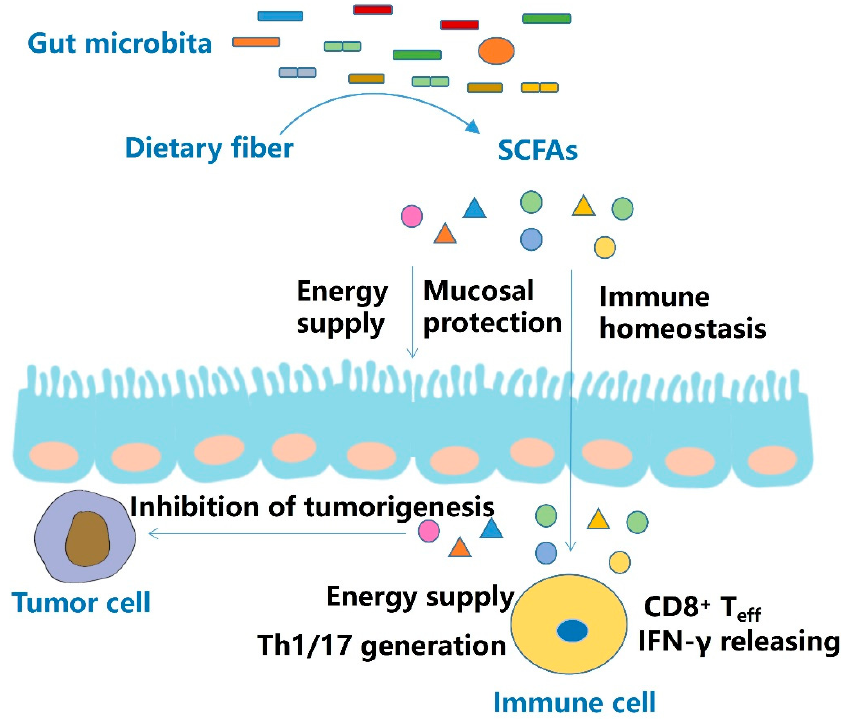
Figure 1. Effect and mechanism of SCFAs. SCFAs are mainly derived from dietary fibers. SCFAs not only provide energy to intestinal cells, but also protect the intestinal mucosal barrier and maintain intestinal immune homeostasis. In addition to suppressing colon tumorigenesis, SCFAs elevate the population of effector T cells (T eff ), promote cytokine release, and enhance immunotherapeutic effi-